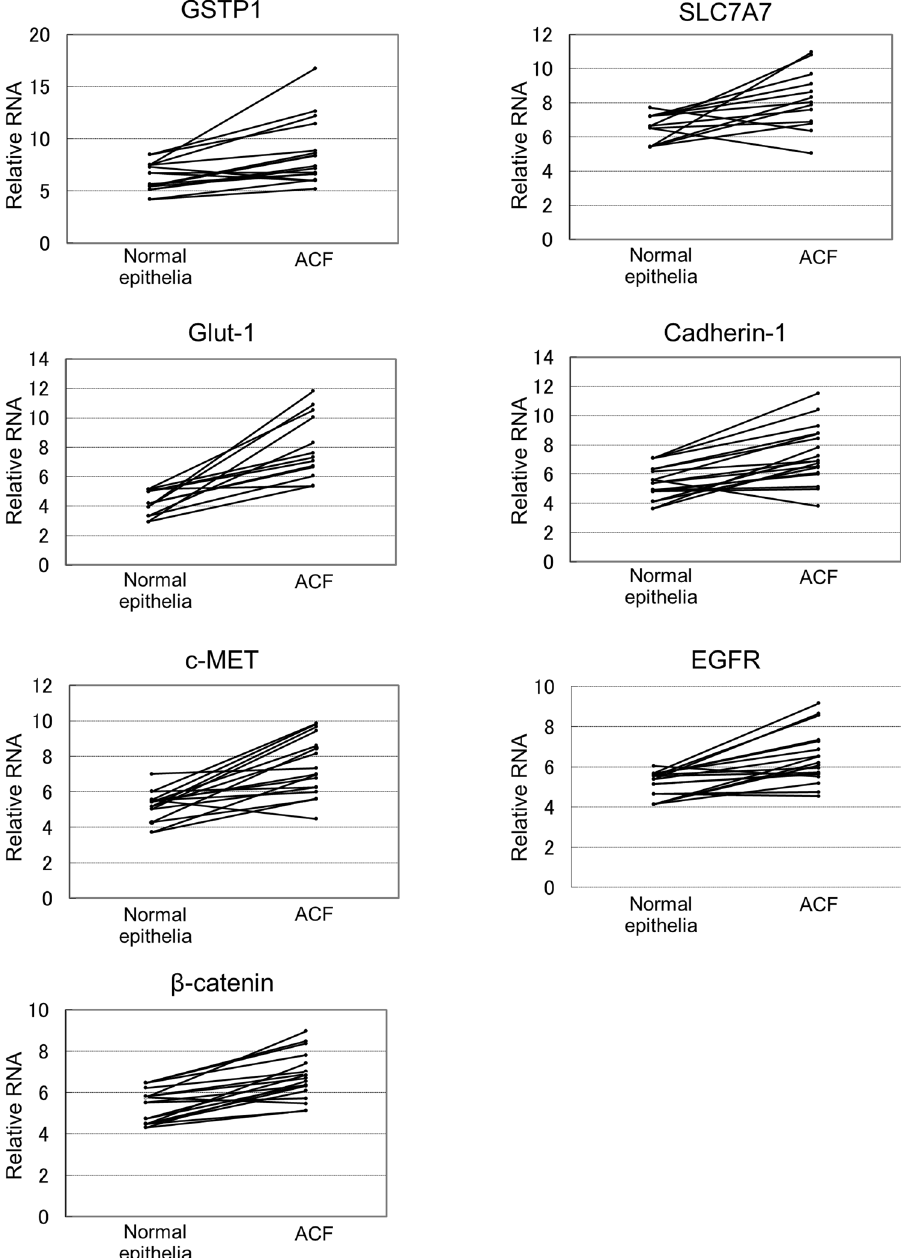
Figure 1. Gene mRNA levels in human ACF tissues. ACF and normal colorectal tissues were biopsied under magnifying colonoscopy. Total RNA was extracted and reverse transcribed, and a TaqMan assay was performed to quantitate mRNA levels for each gene. The 18 S gene was used as an internal